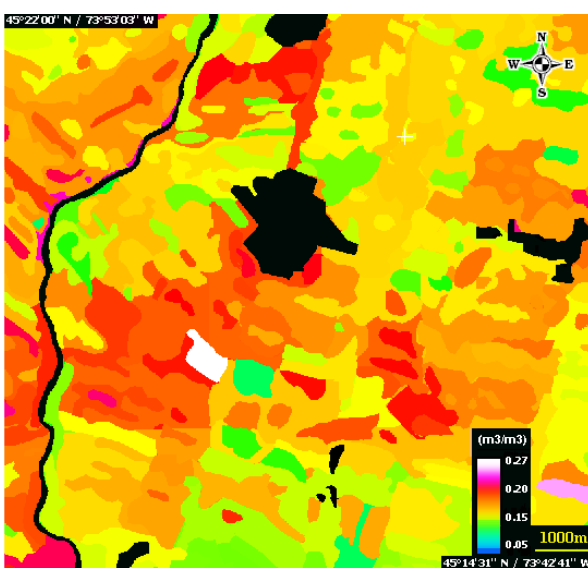
Fig. 15. Flowchart of homogeneous zone calculation.